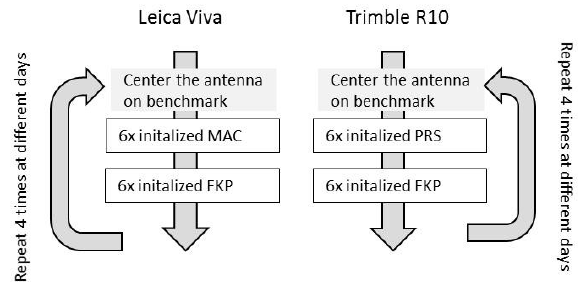
Figure 6: Test procedure for all the test point at the extrapolation area. With Leica Viva receiver MAC and FKP corrections and with Trimble R10 PRS and FKP corrections were used. All corrections came from the NLS